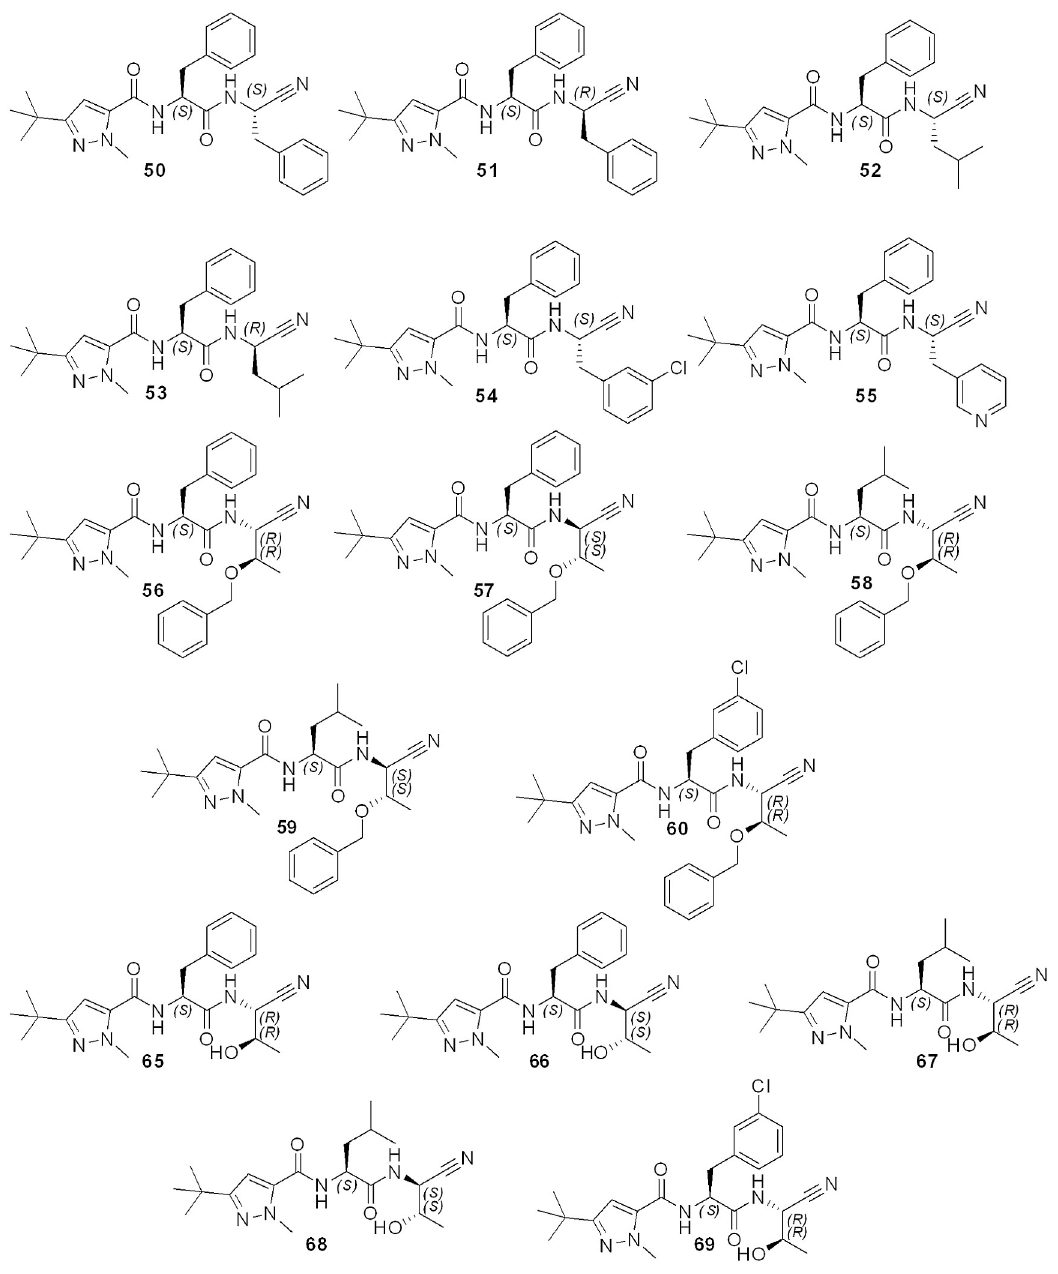
Fig 6. Structure of compounds 50–60 and